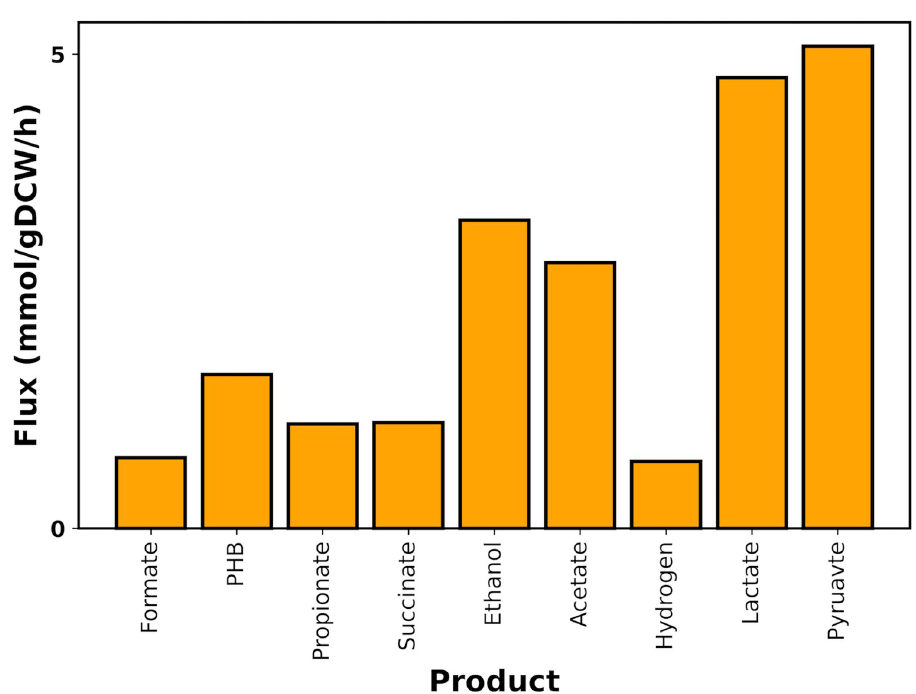
Fig 3. The predicted range of fluxes for by-products in i CN1361 using flux variability analysis, whilst simulating nitrogen-limited conditions.